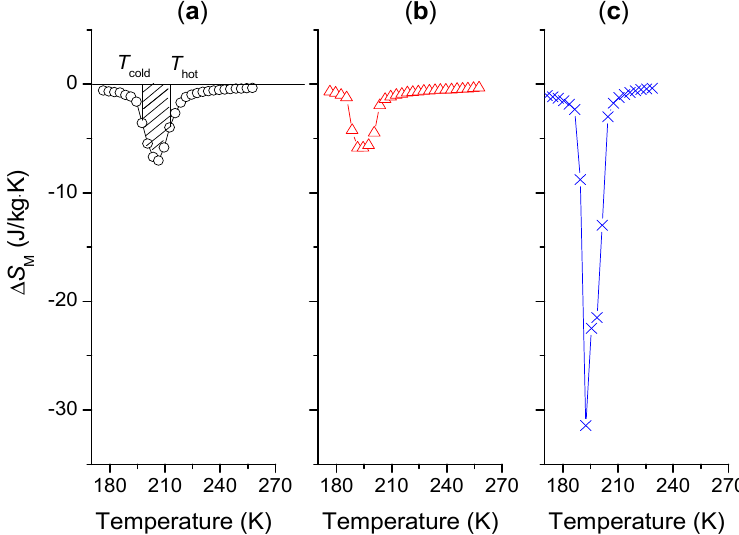
Figure 7. Calculated magnetic entropy changes ( Δ S M ) under a magnetic field change of 3 T for the annealed LaFe 11.6 Si 1.4 ( a ), LaFe 11.6 Si 1.4 Zn 0.03 ( b ), and LaFe 11.6 Si 1.4 P 0.03 ( c ), respectively. Striped area in